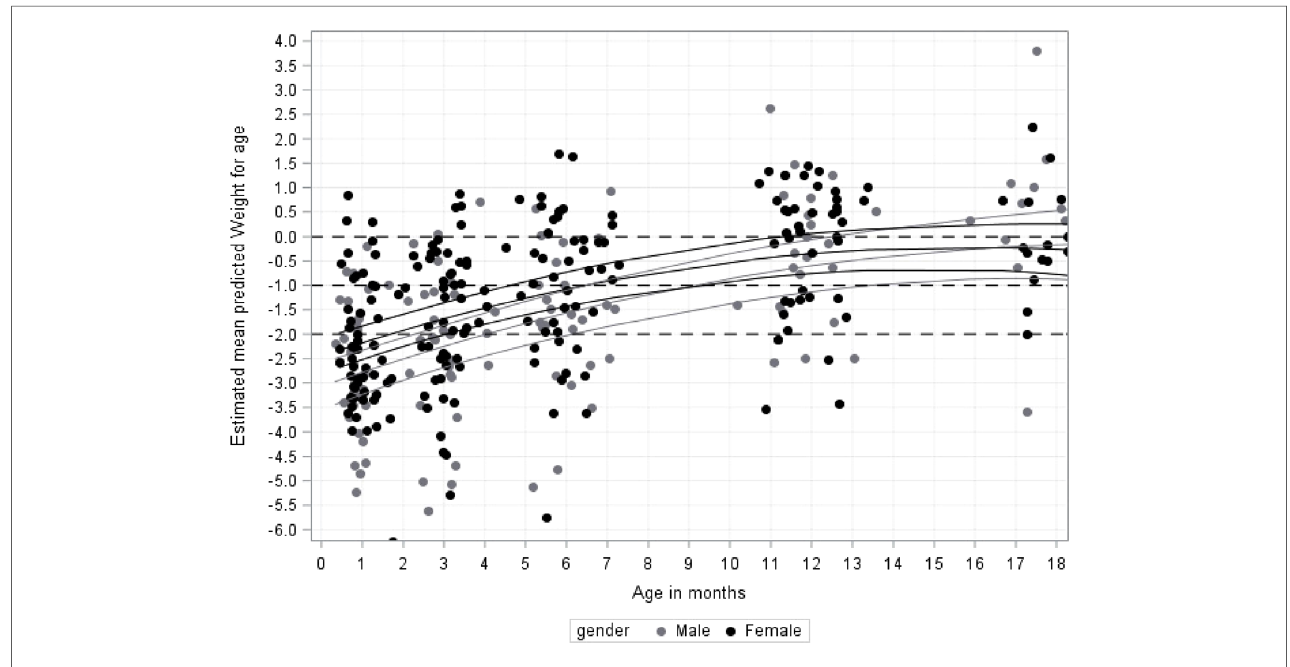
FIGURE 3 Growth for infant ’ s (weight-for-age z-scores (WAZ) in kg from 1 to 18 months by gender.